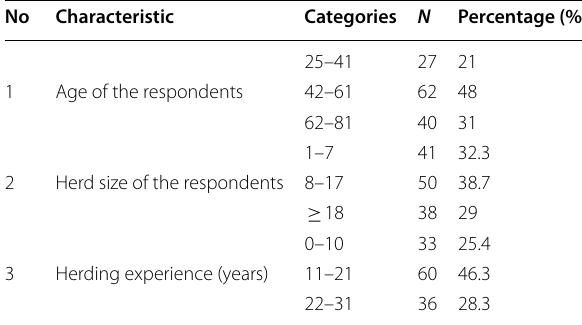
Table 1 Herd profile of the respondents